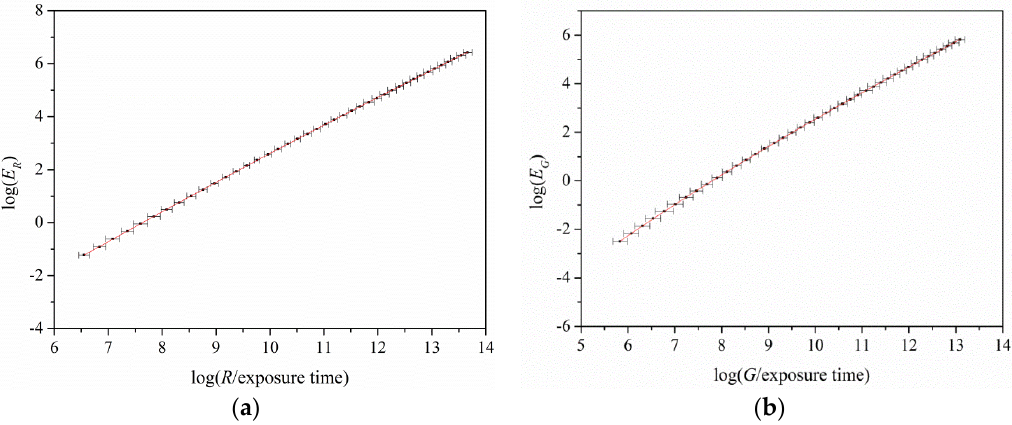
( a ) ( b ) E and ( b ) log( ) E with log( / ) R exposure time and Figure 11. Variations of ( a ) log( ) Figure 11. Variations of ( a ) log ( E R ) and ( b ) log ( E G ) with log ( R / exposure time ) and R G log ( G / exposure time ) , respectively. log( / ) G exposure time , respectively.